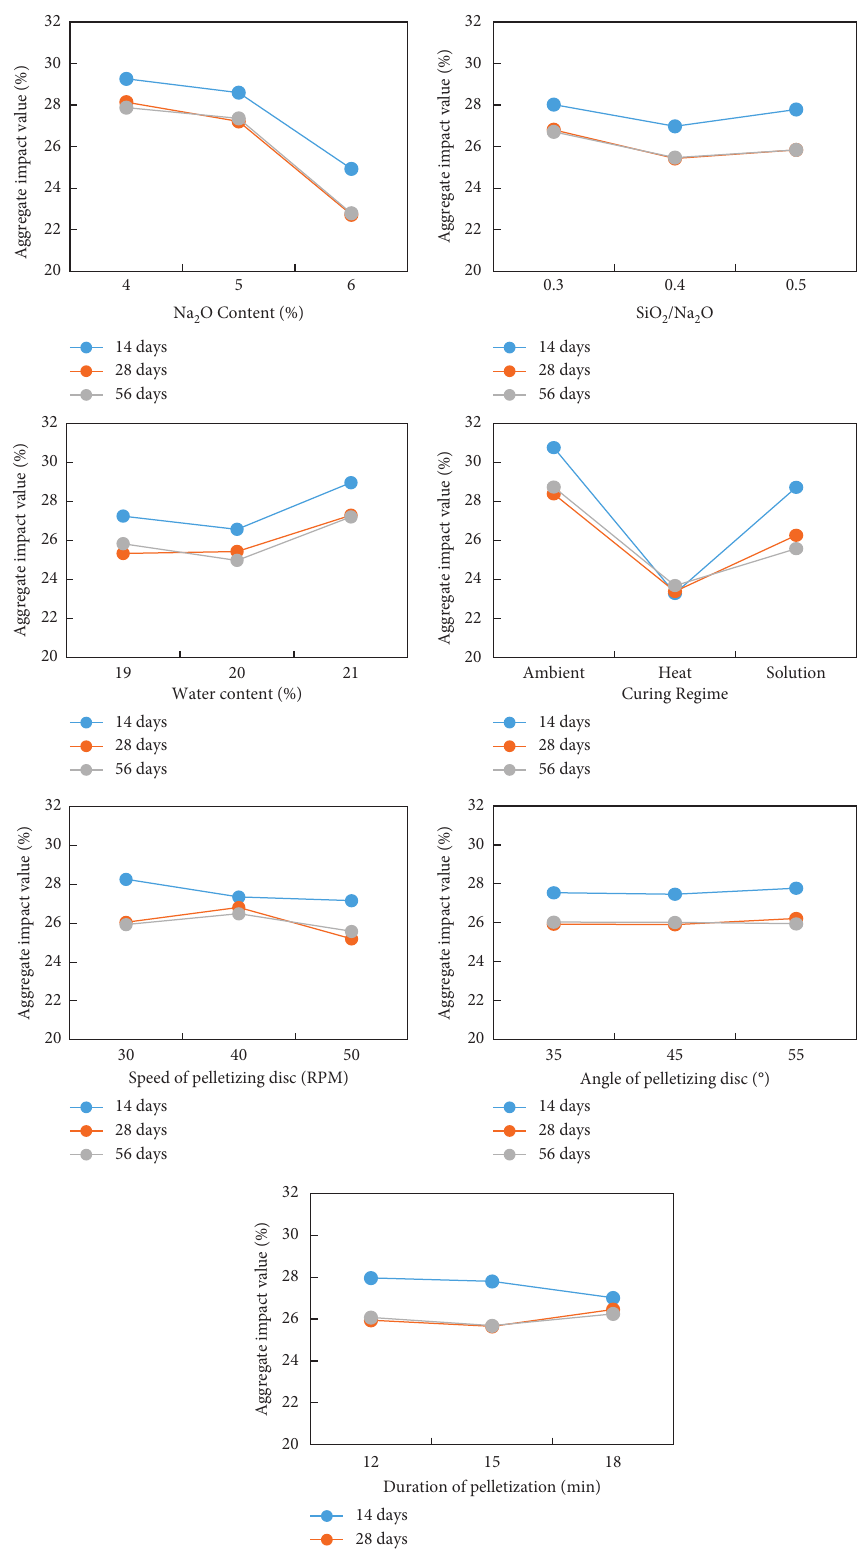
Figure 4: Response index relationship for aggregate impact value with combined